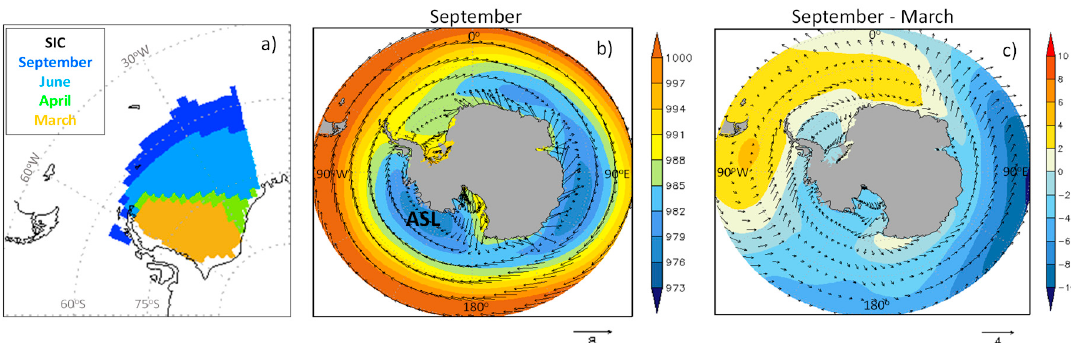
Figure 7. For the period 1980–2015: ( a ) the climatology of the area occupied for SIC values (from NOAA/NSIDC) exceeding 0.4 for four different months: March, April, June and September and ( b ) sea level pressure (hPa, shaded) and wind at 1000 hPa (m/s with scale in the bottom) from ERA-Interim and ( c ) difference between the climatology of September and March of sea level pressure and winds at 1000 hPa.